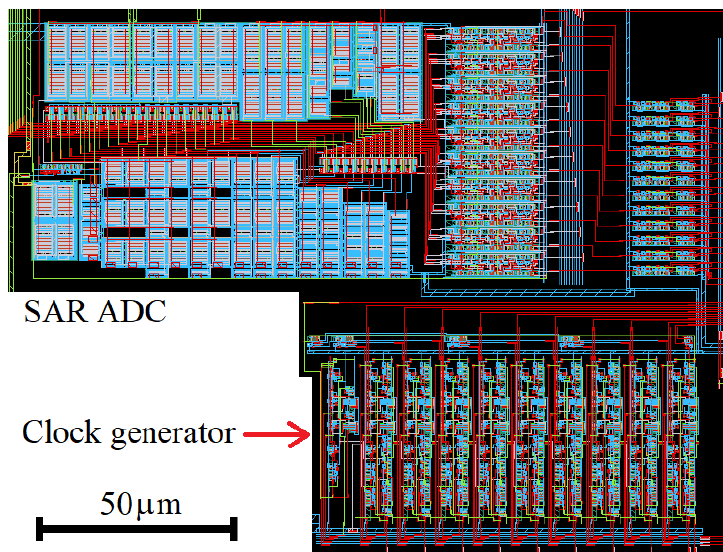
Figure 3. Current-mode successive approximation register analog-to-digital converter (SAR ADC) developed for application in low power sensors with an internal clock generator used to control the conversion